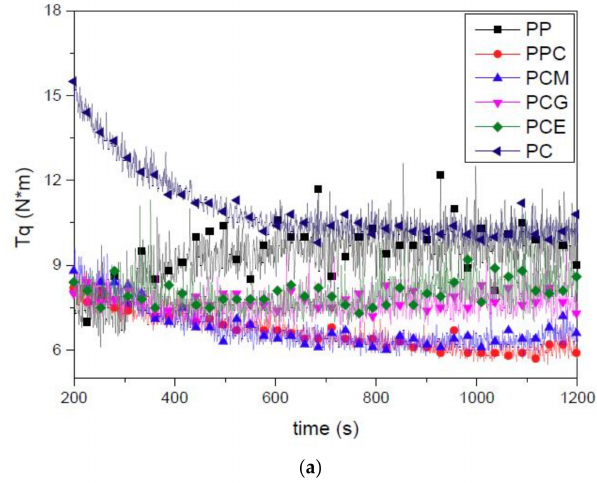
Figure 9. Torque rheological curves (torque vs. time) of the six no-gas PP/PC materials ( a ) and rich-gas PP/PC blends ( b ) and the reduction ratio ( c